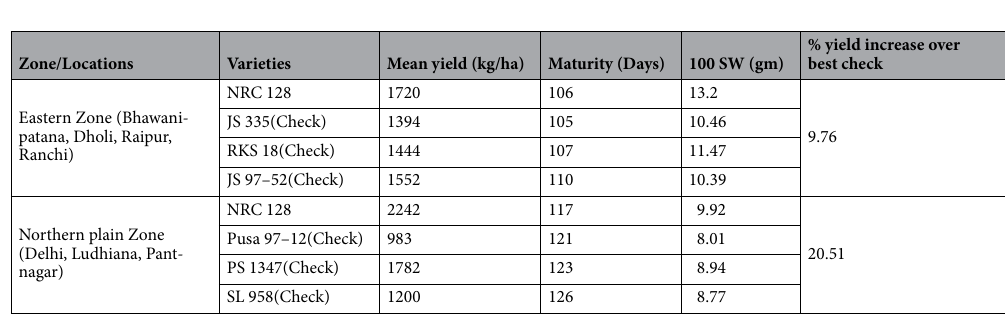
Table 8. Mean performance and superiority for agronomic traits of NRC 128 over best checks in Eastern Zone and Northern plain Zone.